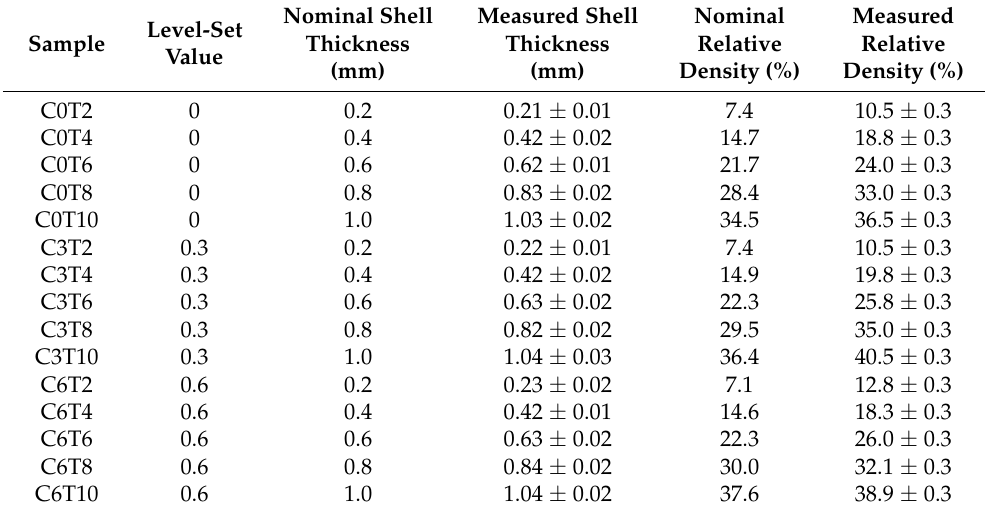
Figure 4. ( a ) The relative density of as-built P-TPMS. ( b ) The predicted value of relative density under different structural parameters.